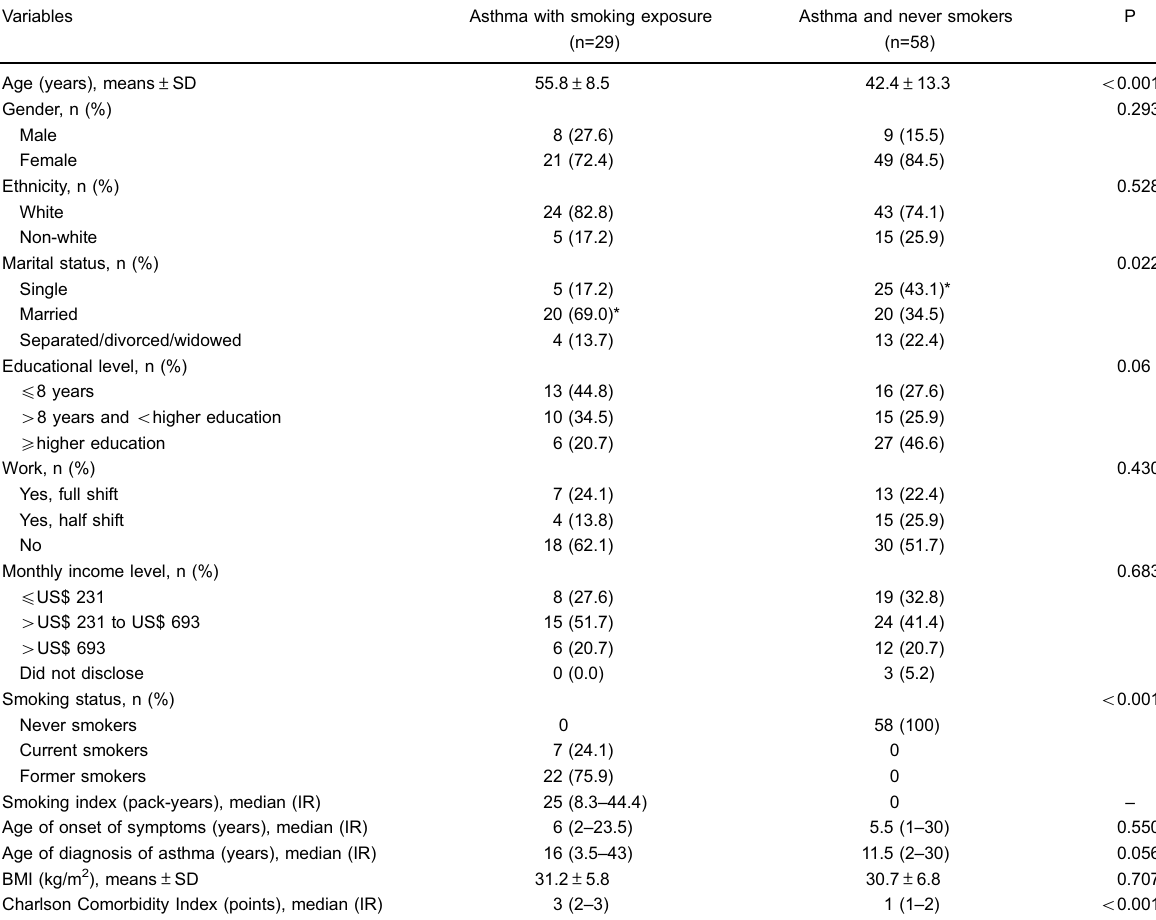
Table 1. Characteristics of the patients.